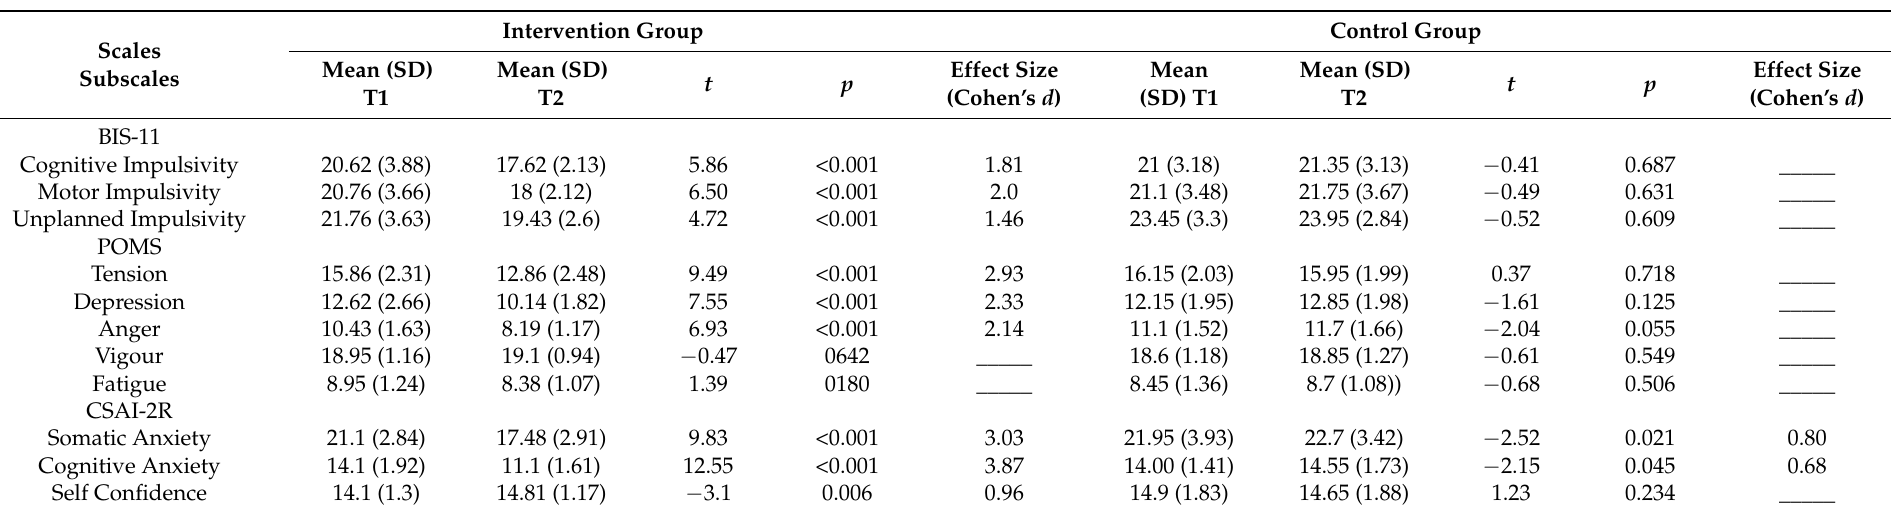
Table 1. Intra-group comparison of T1–T2 measures in the intervention and control groups with t -tests for dependent samples of T1–T2 measures in both groups and effect